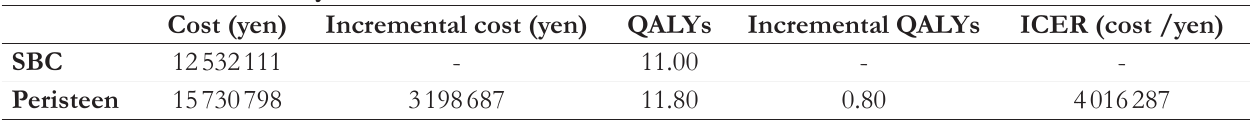
Table 7. Base Case Analysis